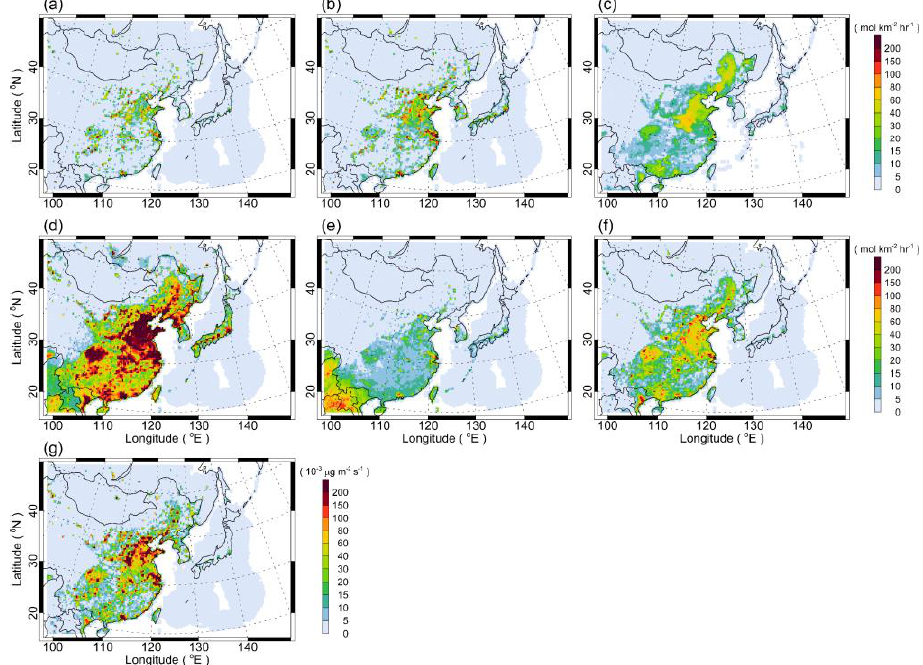
Figure 2. Spatial distributions of anthropogenic emissions over the East Asian domain. ( a ) sulfur dioxide, ( b ) nitrogen oxides, ( c ) ammonia, ( d ) carbon monoxide, ( e ) non-methane volatile organic compounds, ( f ) primary organic carbons, ( g ) particulate matters less than 2.5 (PM 2.5